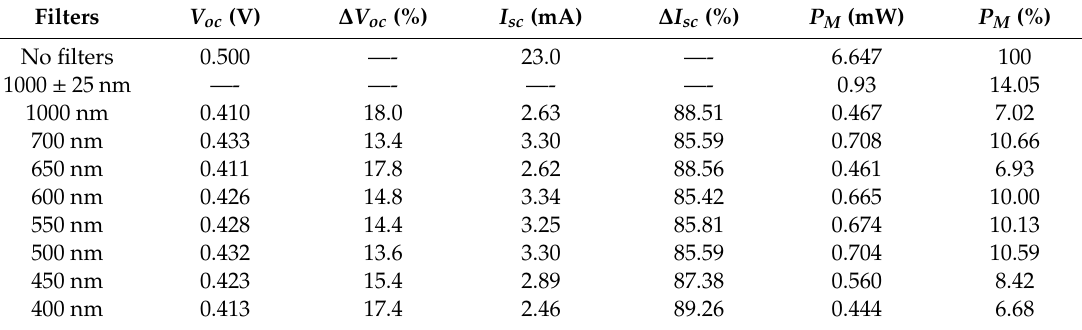
Figure 11. Tests performed with BP filters on 7 August 2018 for the perovskita organic cell. ( a ) Voltage- current curvesa and ( b ) voltage-power curves. Table 6. Values of open circuit voltage, short-circuit current, maximum power, and respective variations for the tests with and without BP filters of m-Si cell for an irradiance of 1000 W/m 2 . Filters